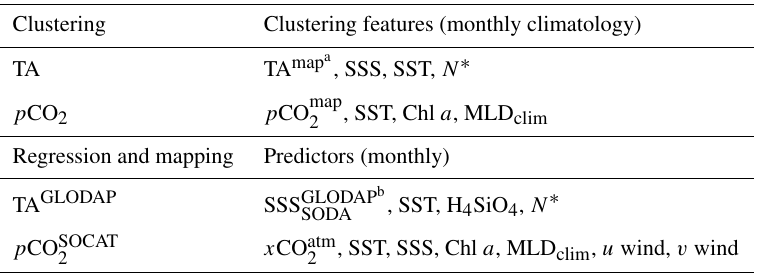
Table 1. Variables used as the clustering features and predictor variables for regression. Details about these data are given in the text. Note that clustering features are all resampled to monthly climatologies. a TA map is the exception where a quasi-annual mean is used. The first column for regression shows the target variable. All machine learning models use the same variables to train and predict the final estimates with the exception of b SSS, where ungridded GLODAP data are used to train and SODA salinity is used to predict. All other references to SSS refer to the gridded SODA product.